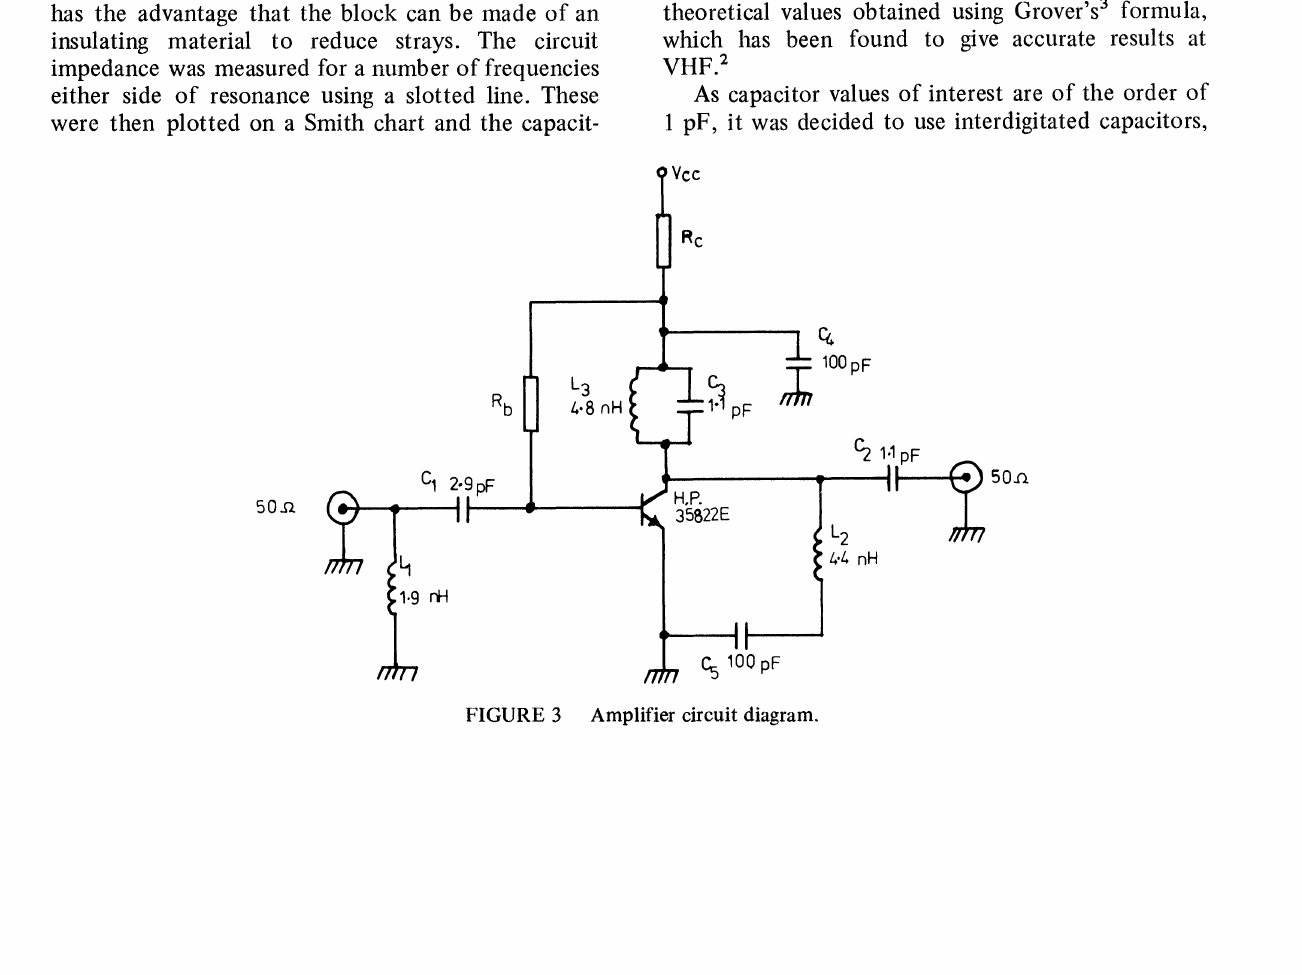
FIGURE 3 Amplifier circuit